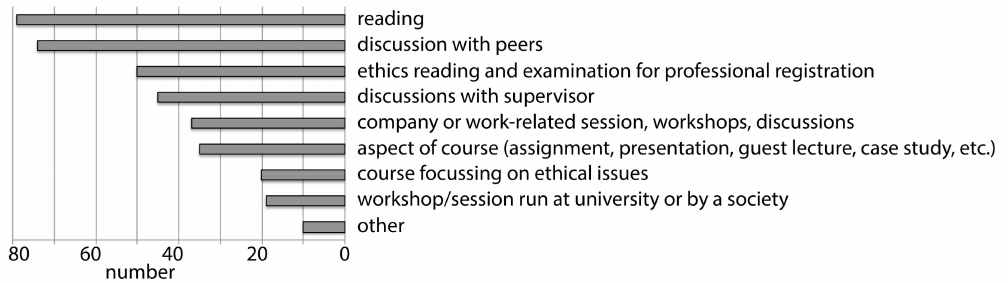
Figure 4. Introduction of respondents to ethical aspects, sorted by incidence.